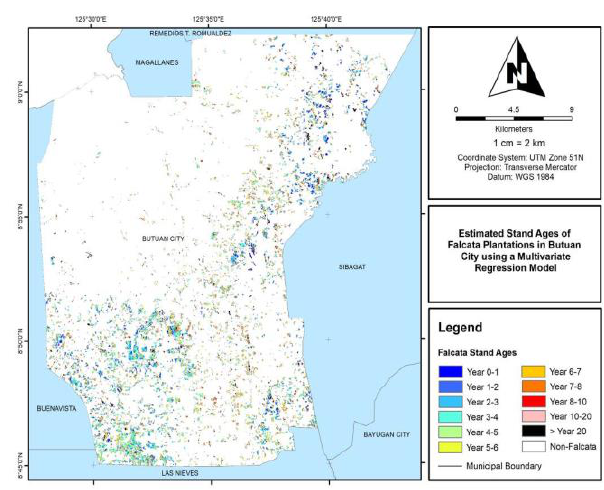
Figure 4 . Falcata stand age map generated using Model 7.